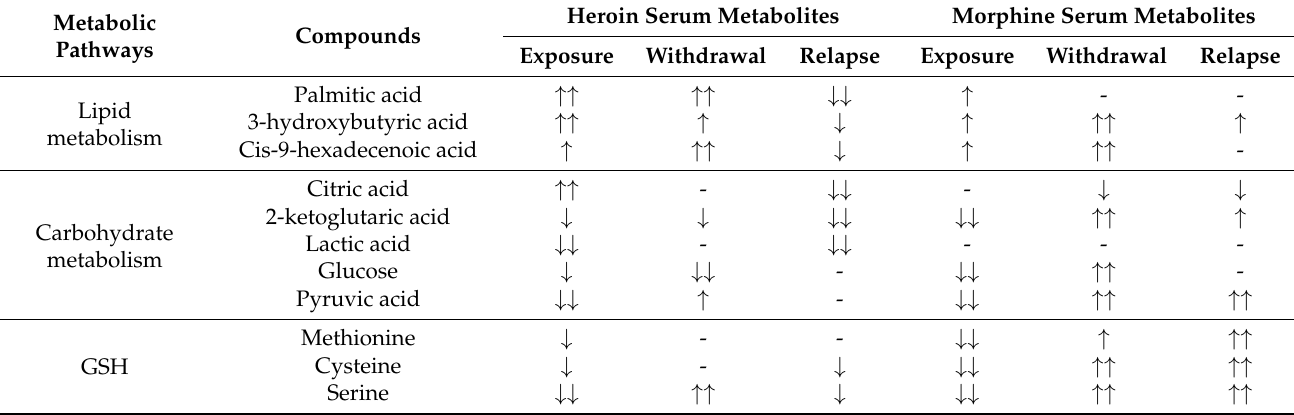
Figure 2. Heatmap of the serum metabolites from mice administered heroin ( A ) and morphine ( B ). Each row corresponds to a specific metabolite; each column corresponds to a set of samples (only group averages are shown). All the values were logarithmically transformed and are expressed as normalized values of the detected abundance of each metabolite. Red to orange indicates high to intermediate relative abundance, whereas orange to yellow indicates intermediate to low relative abundance. Table 1. Overview of the changes of serum metabolites about heroin and